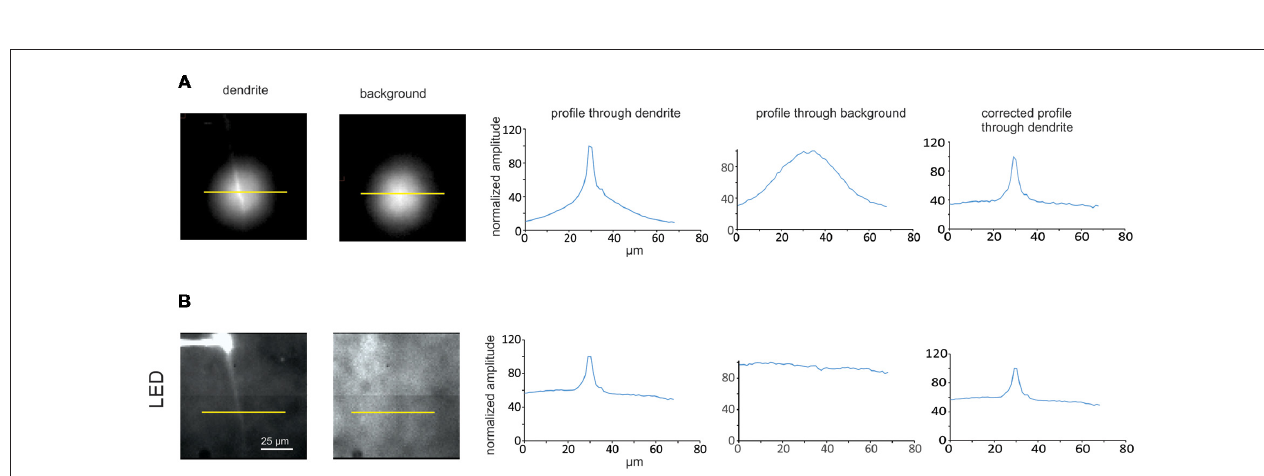
FIGURE 5 | Comparison between LED and laser illumination for separating dendrite fluorescence from background. ( A , left and middle) Images of slices with and without a dendrite in the field of view illuminated by a 377 nm laser through a 200 µ m fiber and a 20 × objective lens (each image has the same field of view as images in B ). The cell was filled with 2 mM SBFI from a patch pipette on the soma. The yellow bars indicate lines along which profiles were measured. ( A , right) Intensity profiles along yellow lines through the two images. The line through the field without the dendrite (background fluorescence) was used to normalize the profile through the dendrite, which is shown in the right trace. ( B , left and middle) Similar images from the same neuron where the dendrite and background are illuminated by a 385 nm LED. ( B , right) Similar profiles through the LED illuminated images. Note that the profile through the background is almost flat, which is due to the wide field illumination by the LED. Importantly, the background level using the laser illumination is less than the background when the LED is used.